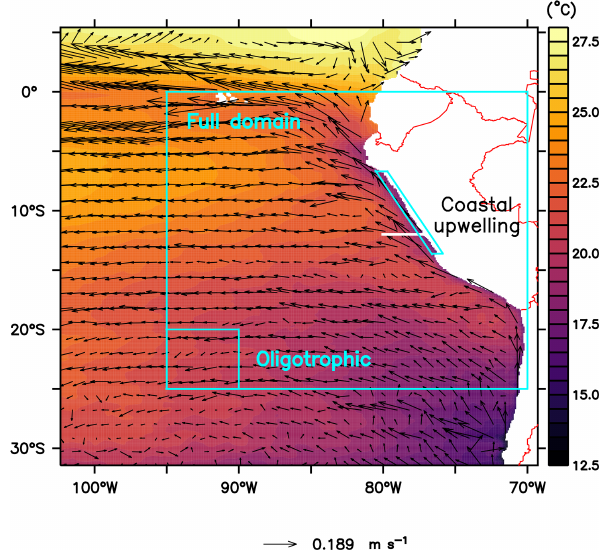
Figure 1. Annually averaged sea surface temperature ( ◦ C) and hor- izontal advection vectors (ms − 1 ) and location of the analysed re- gions (see labels) and of a vertical section for analysing plankton spatial succession (white line at 12 ◦ S). The coastal upwelling re- gion (see Sect. 2.5) spans from the coast to about 40 to 50km off-